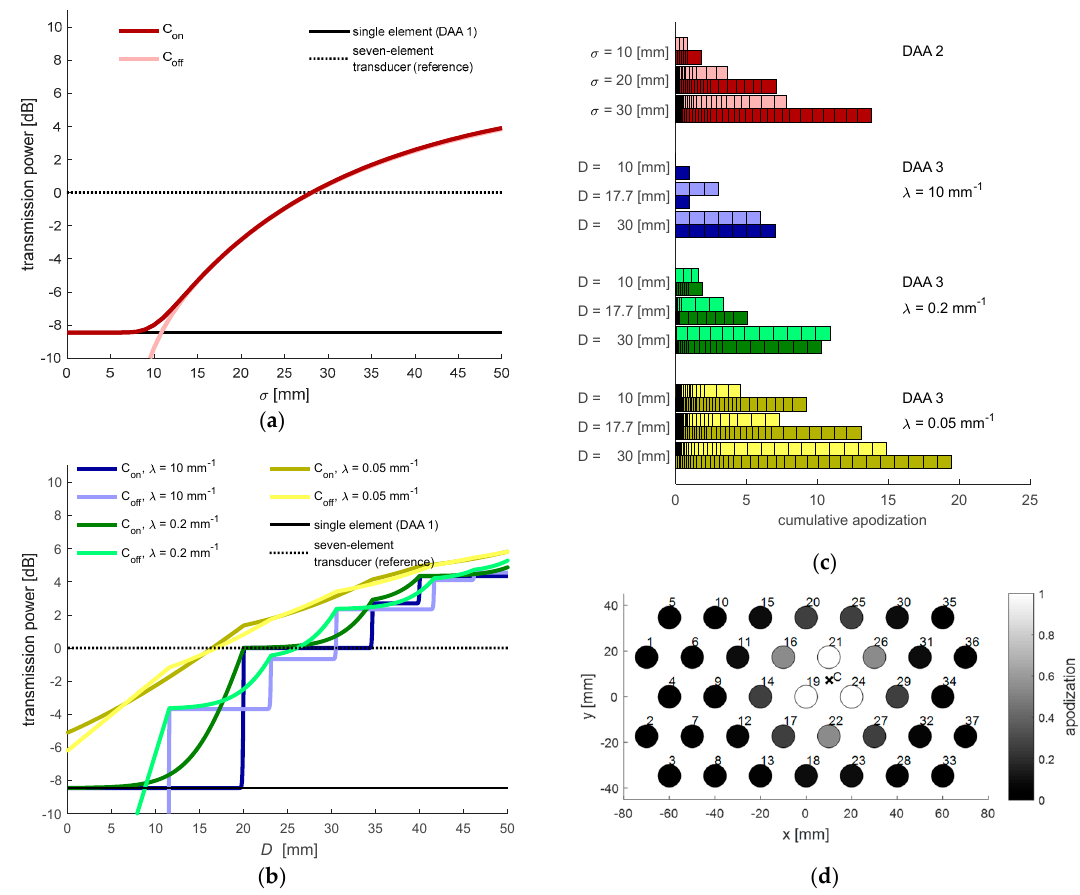
Figure 5. ( a ) Influence of the parameter σ (DAA2) on the total transmission power. The dark- and light-colored lines indicate the total transmission power depending on whether the power center C coincides ( C on ) with an element position or if it lies in between elements ( C off ). As reference, the dashed line at 0 dB indicates the total transmission power of a seven-element transducer used in clinical practice and the solid line is the transmission power when only a single element is used; ( b ) Influence of the parameter D (DAA3), for three selected decay parameters λ ; ( c ) Cumulative apodization, the added apodization values set in all transducer elements, for selected parameter settings. Each block in the stacked horizontal bar plots corresponds to the apodization value of a single transducer element. The light and dark colored blocks correspond to the set apodization depending on whether the power center C coincides ( C on ) with an element position or if it lies in between elements ( C off ); ( d ) 2-dimensional representation of set apodization function with specific parameters (DAA3, D = 17.7 mm, λ = 0.05 mm − 1 ).